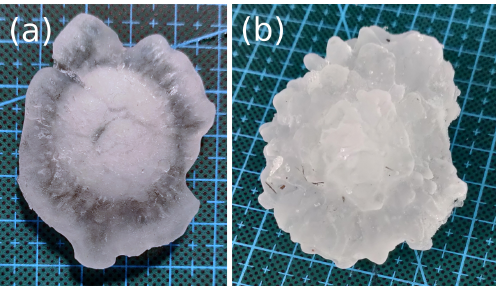
Figure 2. Examples of the two main hailstone shapes observed: (a) highly oblate, partly melted hailstones without lobes and (b) larger, approximately spherical opaque hailstones covered in many small lobes. Photographs were captured prior to the extrac- tion of cross sections. These hailstones are identified as numbers 5 and 4, respectively, in subsequent